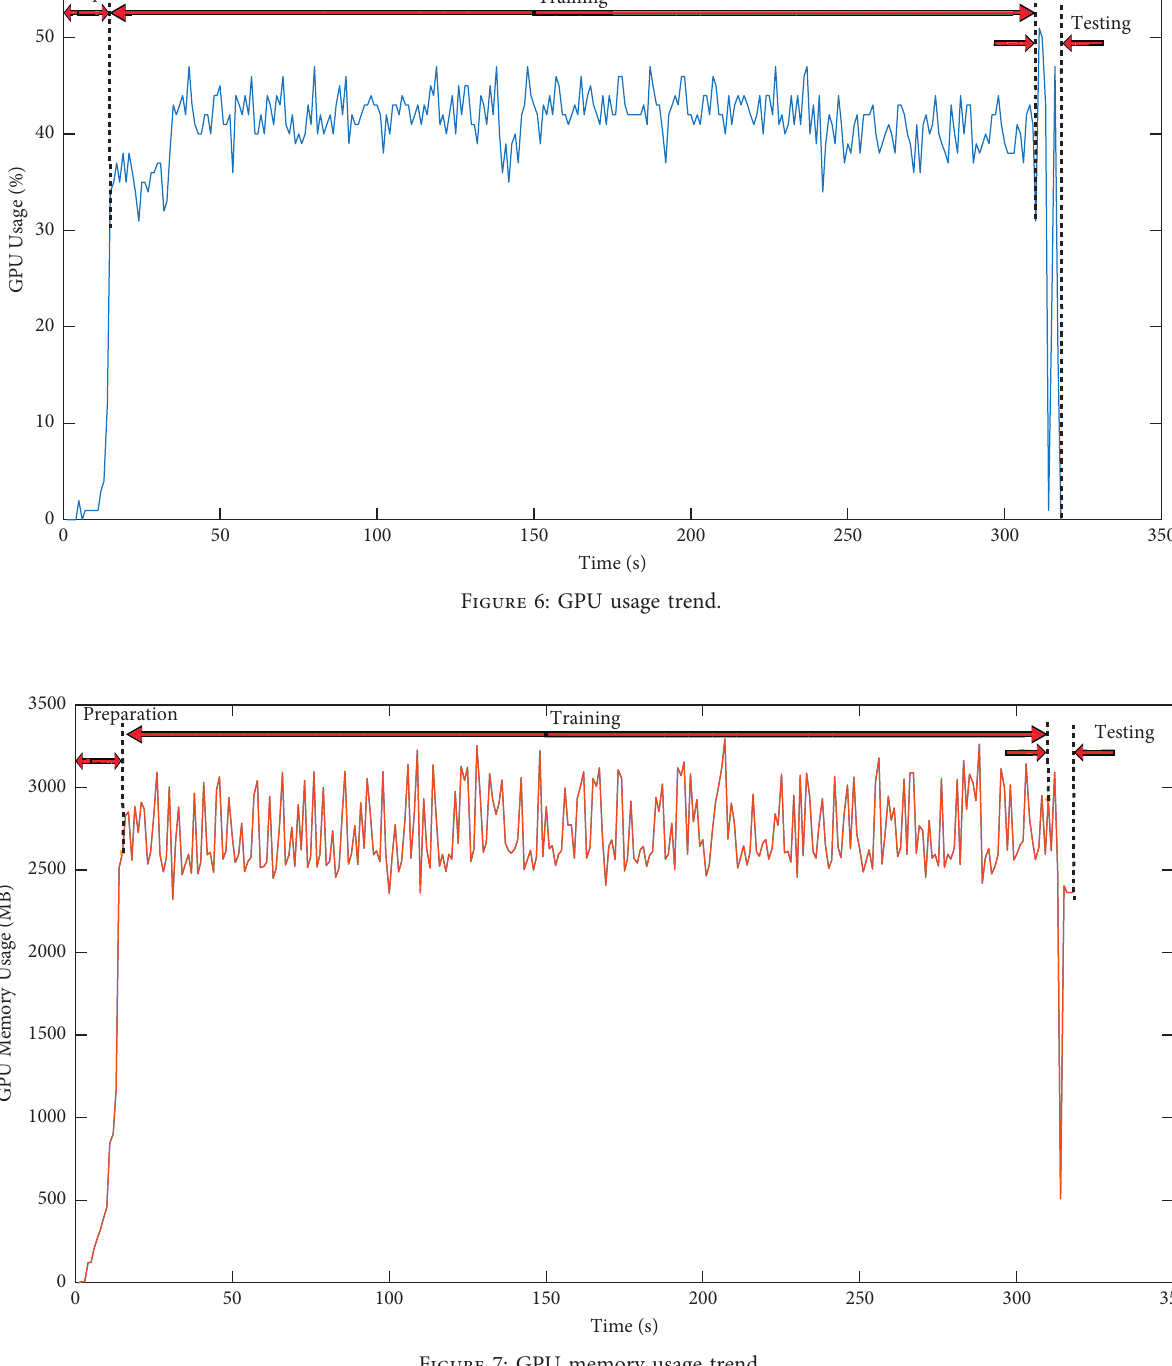
Figure 6 is a GPU usage trend when the movements classification algorithm is running. The preparation process means the initial run of the algorithm program. At this time, GPU usage and GPU memory usage are nearly zero. In Figure 7, the DBDF network training causes over 30% GPU